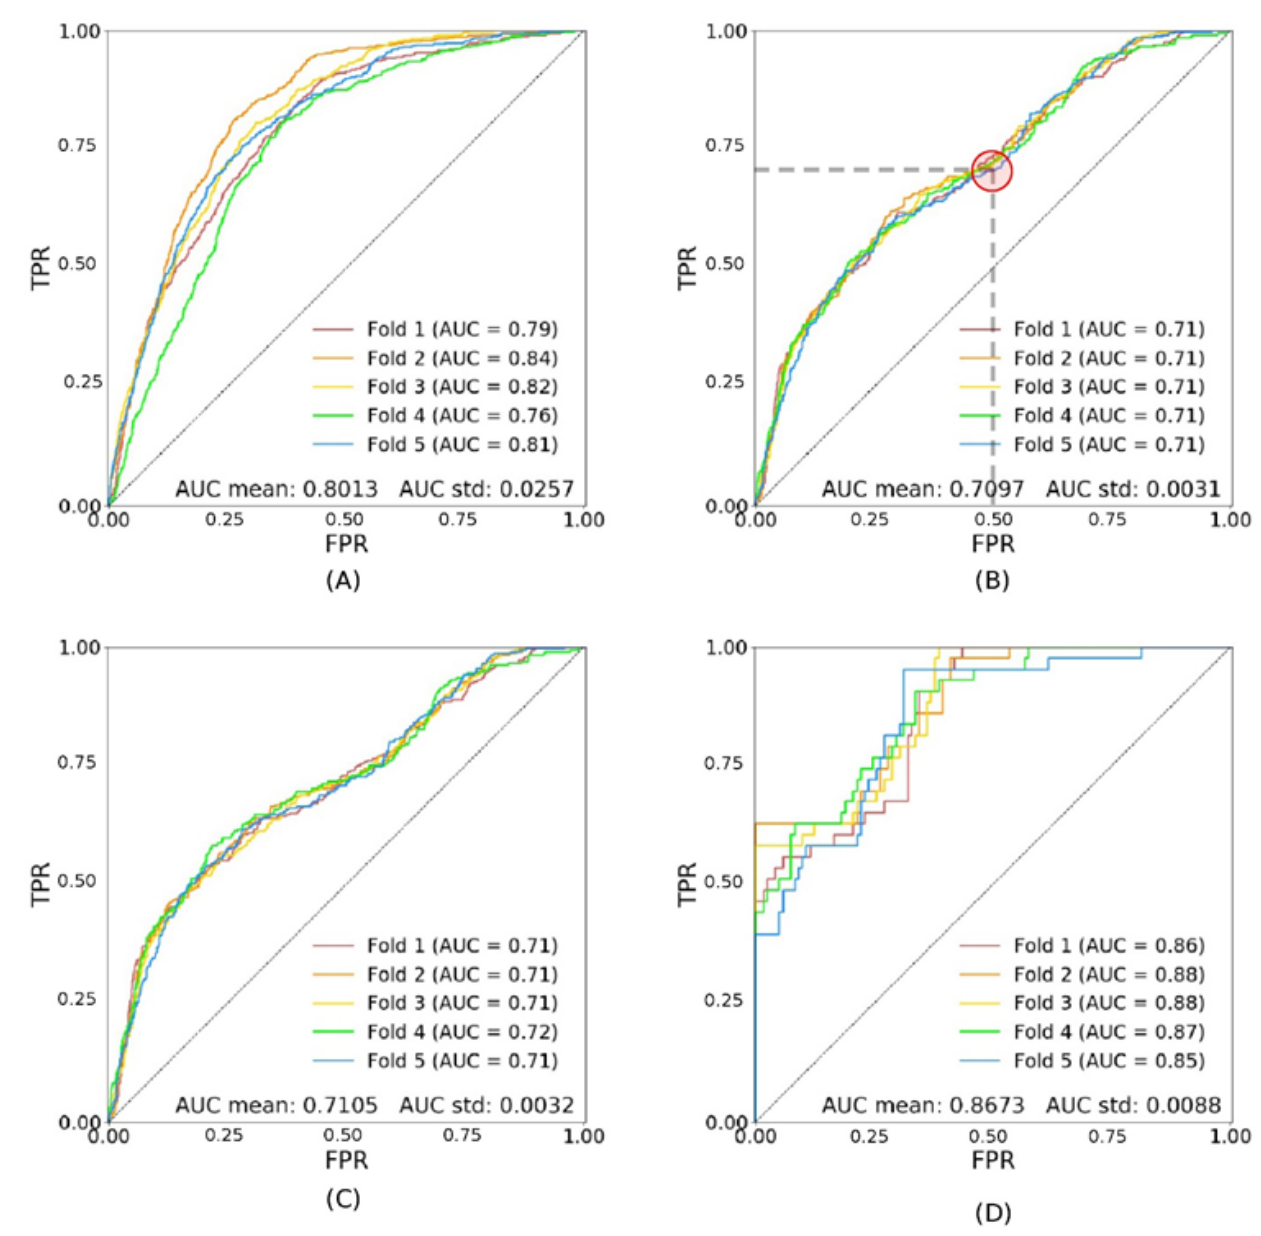
Figure 2. Shows the performance of the model trA (trained on all patients). Image ( A ) shows the ROC curves for the validation set (val); ( B ) shows the ROC curves for the test set with all patients (tsA), the red circle is a representative point on the curve, with 70% TPR and 50% FPR (see text for further details); ( C ) shows the ROC curves for the test set with patients without DR only (tsDR−); ( D ) shows the ROC curves for the test set with patients with DR only (tsDR+).